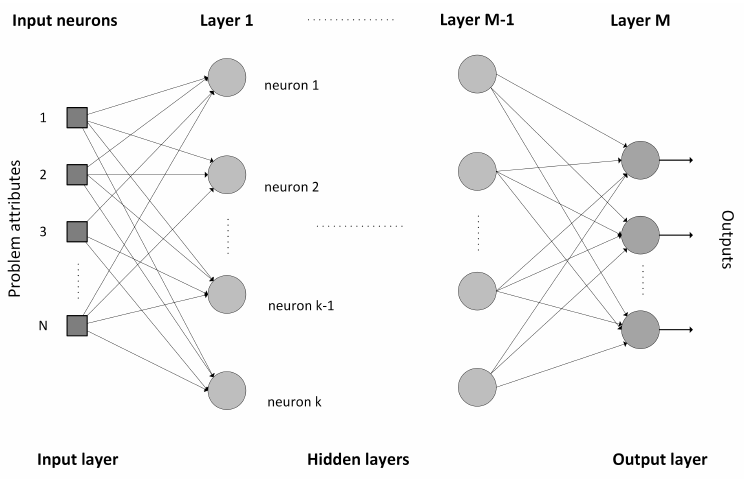
Figure 1. MLP ANN